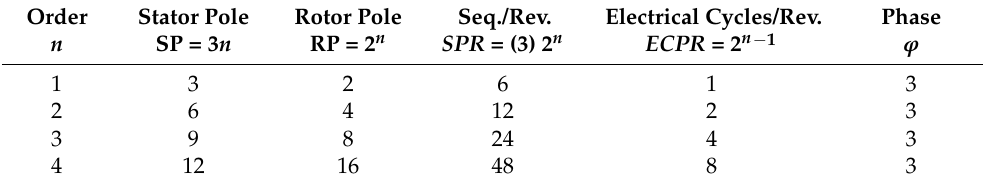
Table 2. Analysis of 3 n poles in the stator and 2 n